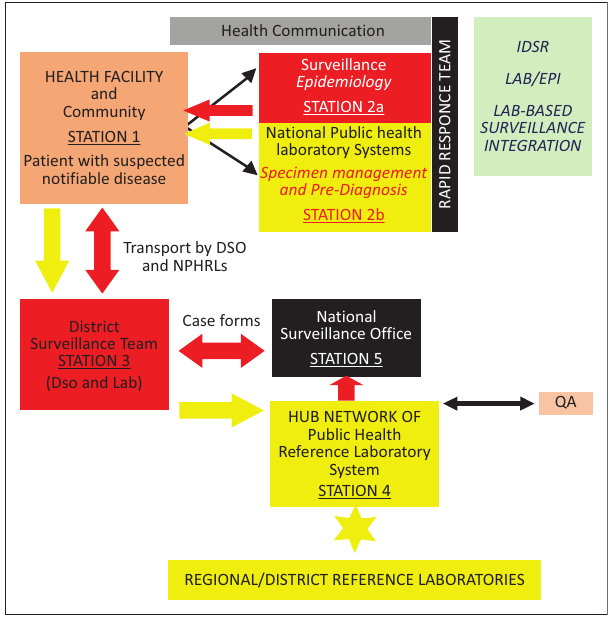
FIGURE 2: Framework for the reconstruction of laboratory system